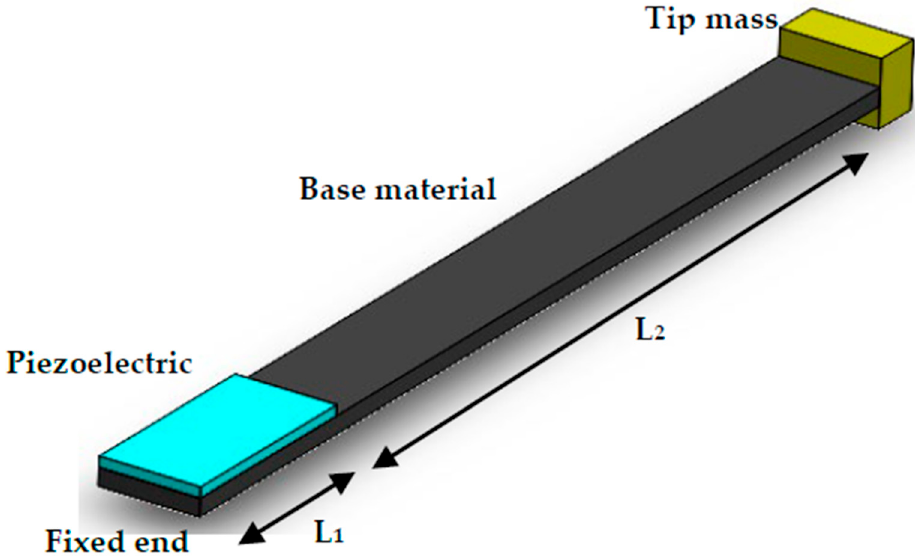
Figure 1. The diagram of the piezoelectric harvester with the tip mass, L 1 represents the composite segment of the beam with the active layer of PZT and the beam substructure, L 2 represents a single layer of the substructure of the beam [3].